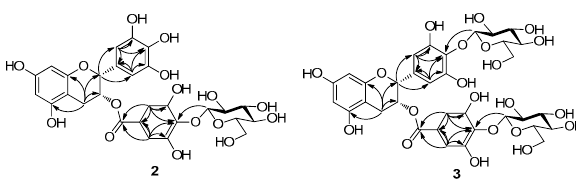
Figure 2. HMBC correlations of EGCG-G1 ( 2 ) and EGCG-G2 ( 3 ).